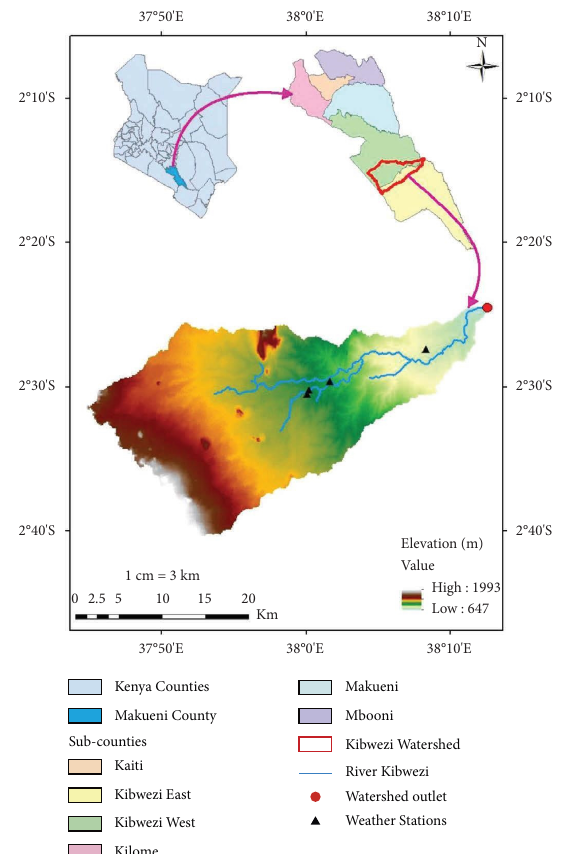
Figure 1: Kibwezi watershed